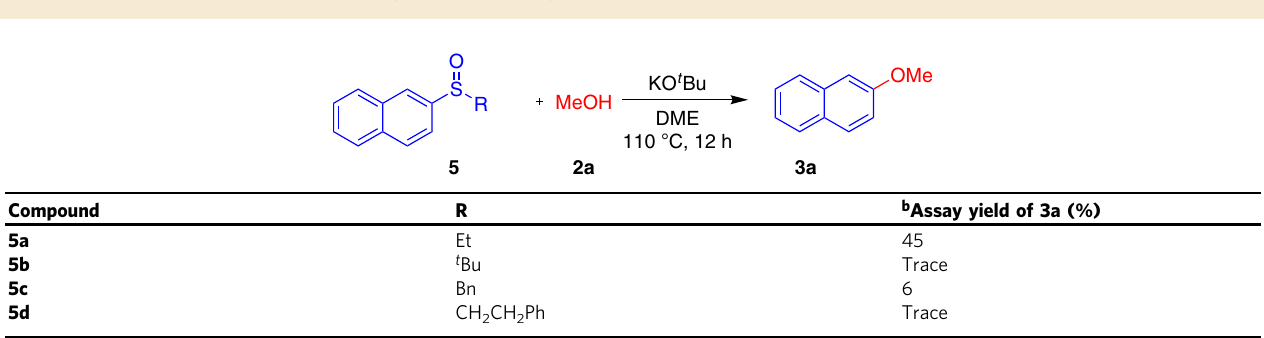
Table 2 Transition-metal-free cross-coupling of alkyl aryl sulfoxides with methanol a